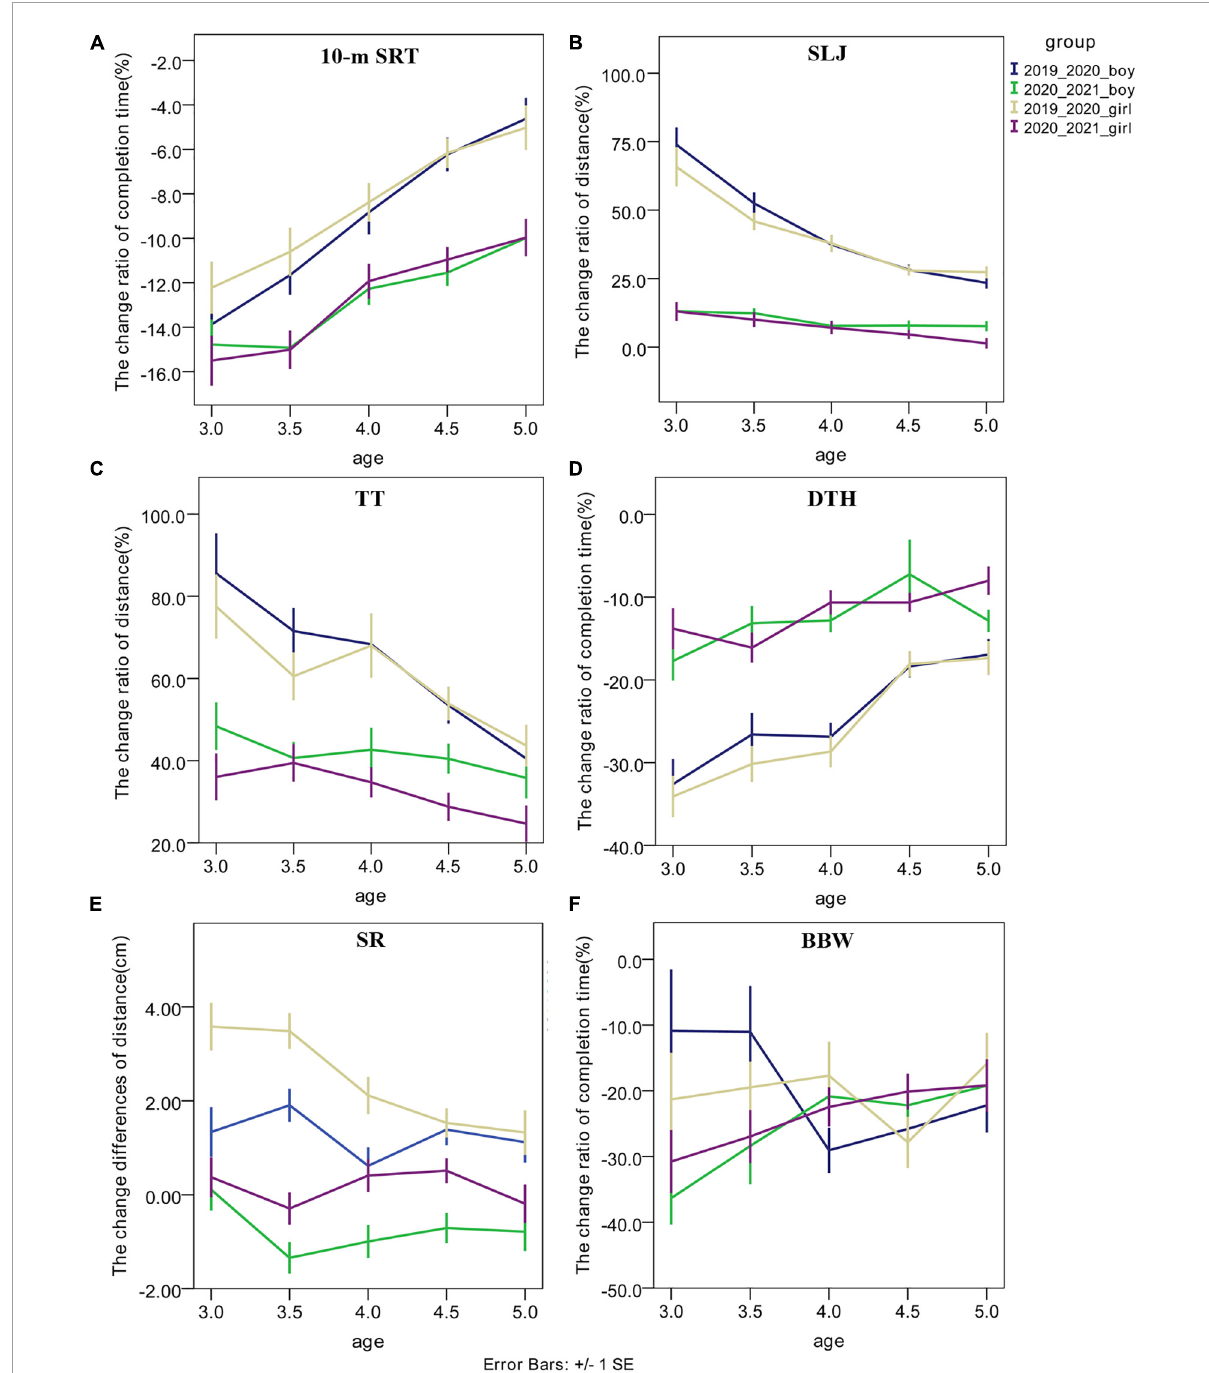
FIGURE2 The change ratios or change difference in the six subtests of NPFM between 2020 and 2019 and between 2021 and 2020. (A) for 10-m SRT; (B) for SLJ test; (C) for TT test; (D) for DTH test; (E) for SR test; (F) for BBW test. SRT denotes 10-m shuttle run, SLJ denotes standing long jump, TT denotes tennis throwing, DTH denotes double-leg timed hop, SR denotes sit-and-reach, and BBW denotes balance beam walking.